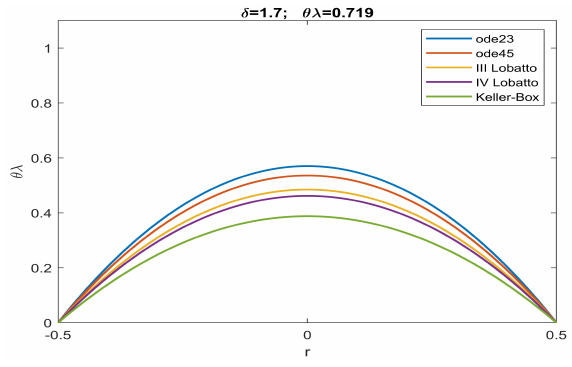
Figure 7. Recovering of u ( r ) for δ = 1.7 and θλ =